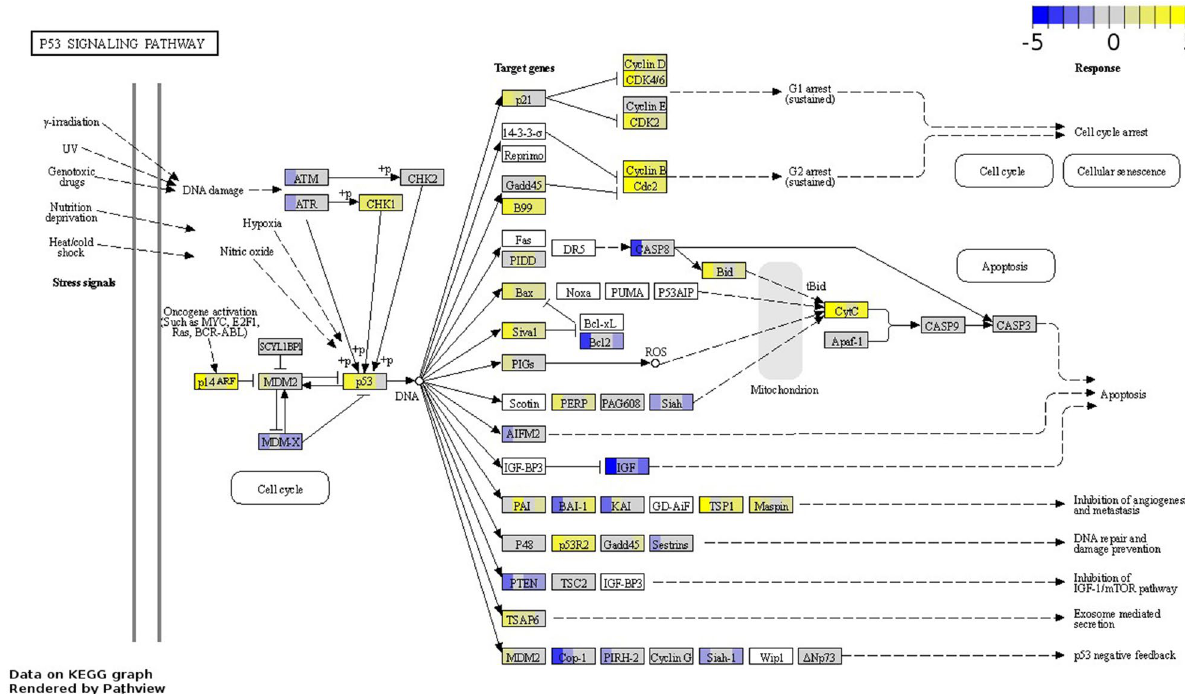
Figure 2. Differentially expressed genes associated with the p53 signalling pathway (fca04115) across all sample groups. The boxes illustrating DEGs are uniformly divided by the number of sample groups; representing from left to right: CLs, LB f HER2− tumours, normal-like TN tumours, and basal-like TN tumours. Gene log 2 fold- change relative to controls is indicated in yellow (upregulated) or blue (downregulated), white boxes represent genes not detected. Data on KEGG graph rendered by “Pathview” (https:// pathv iew. uncc.